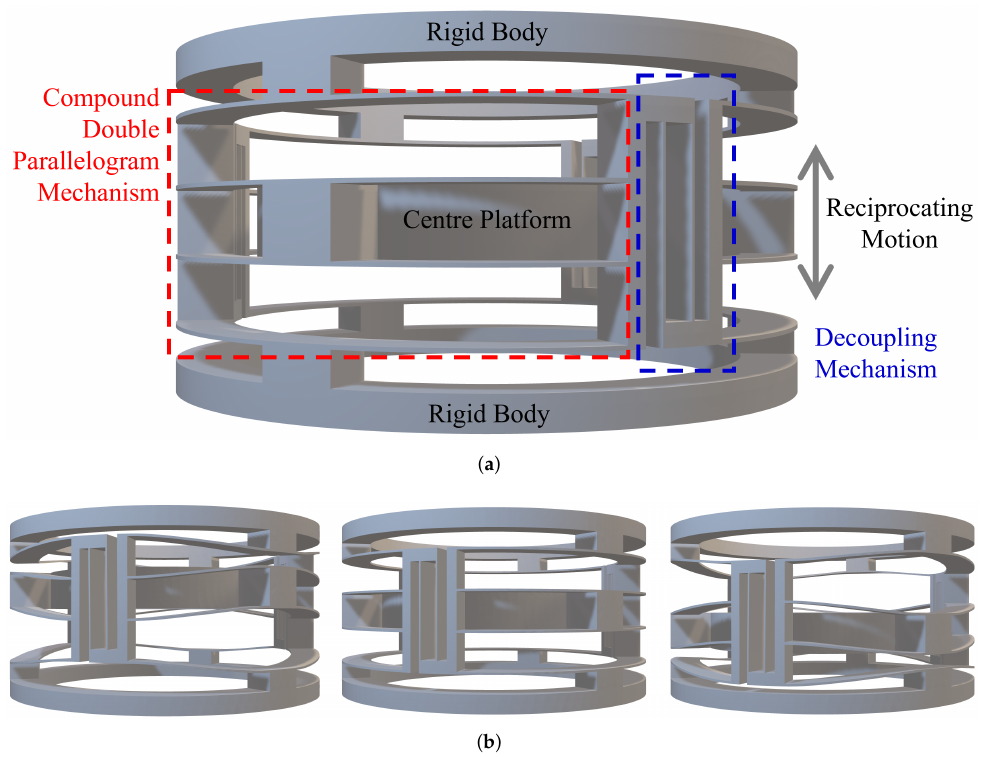
Figure 4. The 3D model of the decoupled linear guide. ( a ) The geometrical design and explanation. ( b ) The deformation process of the decoupled linear guide.